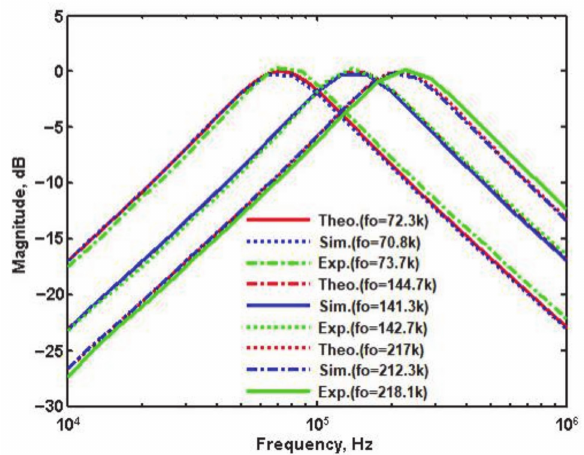
Figure 14. Gain characteristics of the BPF with different f o .